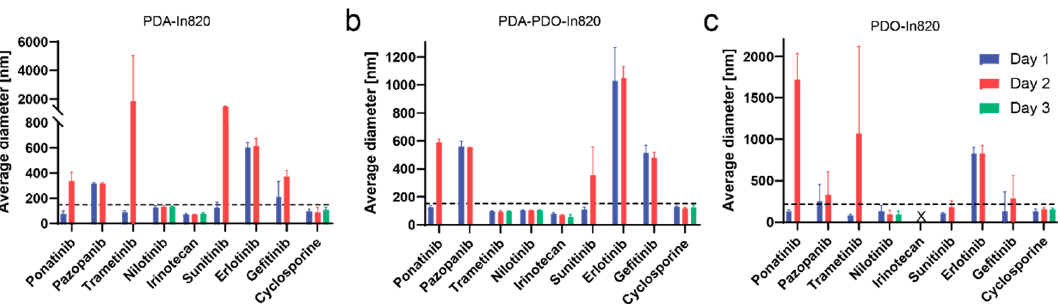
Figure 3. Three-day stability of 9 drugs stabilized by ( a ) PDA-In820, ( b ) PDA-PDO-In820, and ( c ) PDO-820. ( c ) PDO-820.